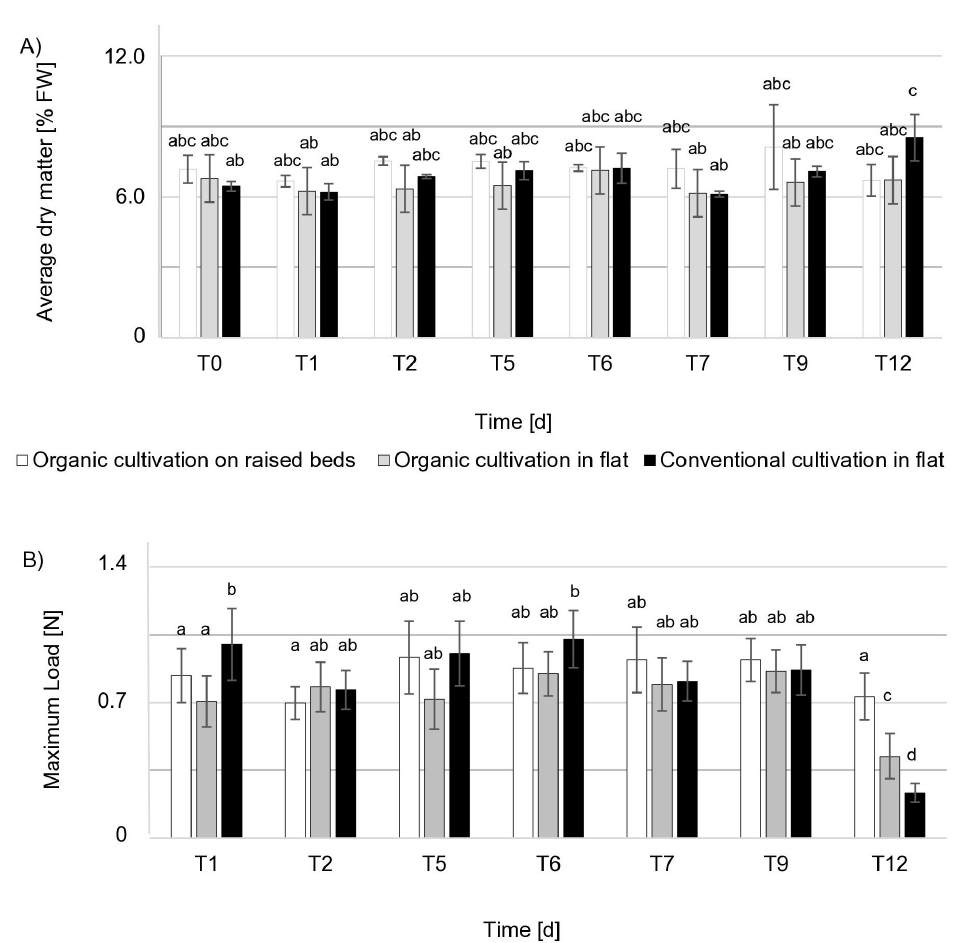
Figure 2. Fruit quality attributes. Average dry weight ( A ) and firmness ( B ) changes over storage time. T0—harvest day, T1–T12—days of sampling. Letters indicate the differences (a, b, c, d) between cultivation methods and storage days ( p < 0.05), determined by Tukey’s HSD test. Data are means ± SD (n = 3).